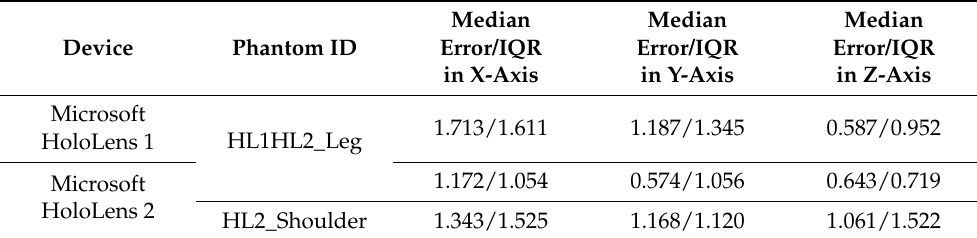
Table 4. Median error of AR control points per phantom, device, and